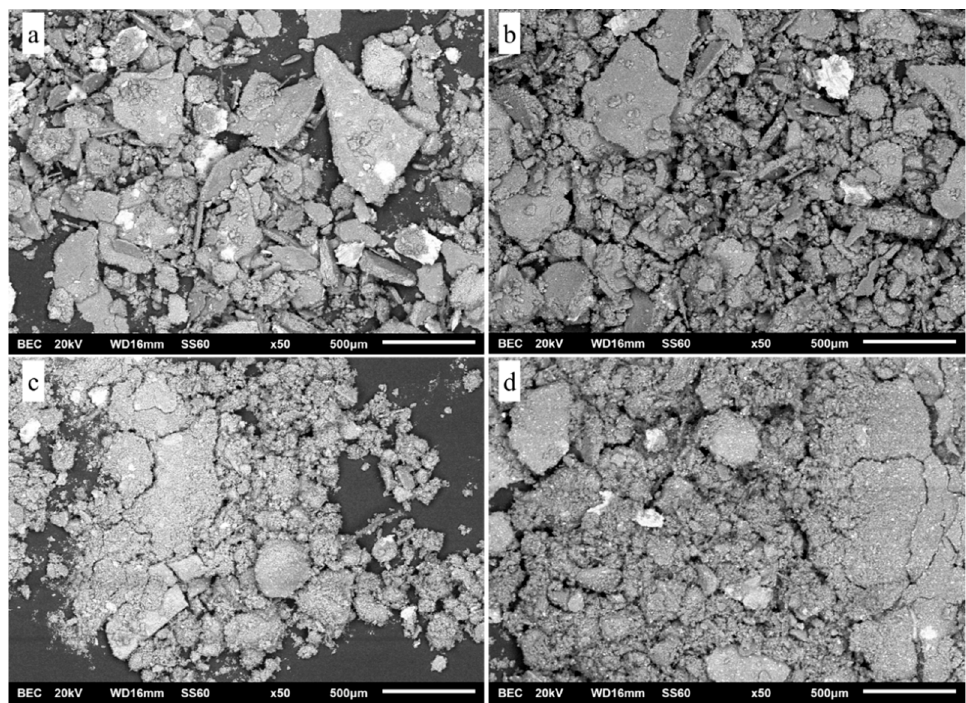
Figure 13. SEM images for debris from the monolithic matrix ( a ) and 1% ( b ), 3% ( c ), and 5% ( d ) vol. reinforced systems, respectively.